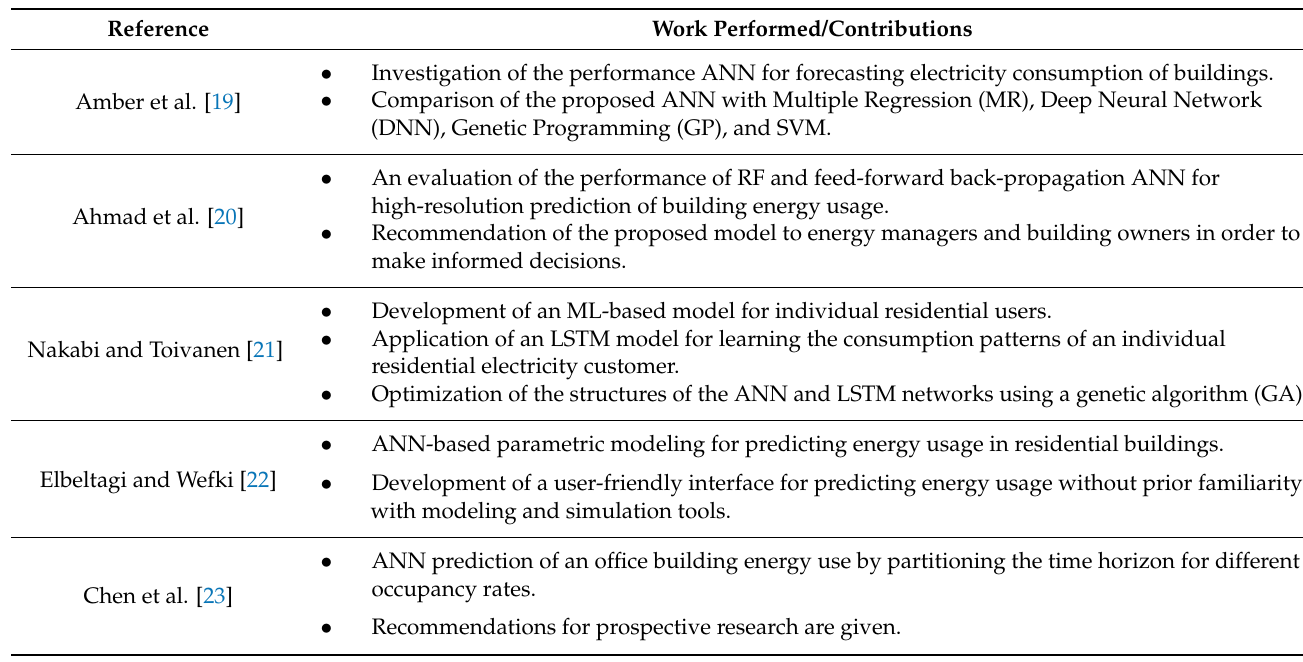
Table 1. Summary of the contributions of previous